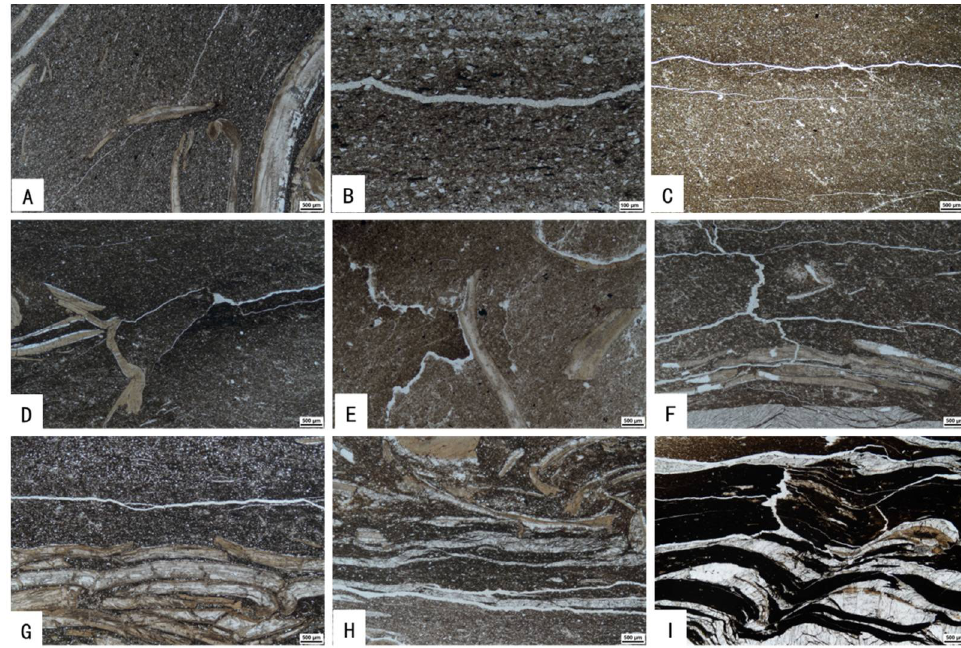
Figure 2. Photograph of typical micro-fractures under shale thin section. ( A ) YL30-2, 3597.36 m, mudstone with shell, micro-fractures cutting through shell particles; ( B ) YB21-2, 4026.05 m, mudstone, micro-fractures along the bedding unfilled; ( C ) YL30-24, 4007.5 m, mudstone, nearly parallel micro-fractures in mudstone; ( D ) YL4-6, 3748.38 m, mudstone, micro-fractures extending along the edge of the shell into the mudstone, unfilled; ( E ) YL4-12, 3753.38 m, mudstone, along the shell micro-fractures extending from the edge to mudstone, unfilled; ( F ) YL4-16, 3756.4 m, calcareous mudstone, interlayer fractures and nearly parallel fractures connected into a network; ( G ) YL17-2, 3864.22 m, calcareous mudstone, unfilled micro-fractures; ( H ) YB102-6, 3922.79 m, shell mudstone, micro-fractures, severe silicification of bioclastic edges; ( I ) FY1-1, 2571 m, calcareous mudstone, networked micro-fractures in